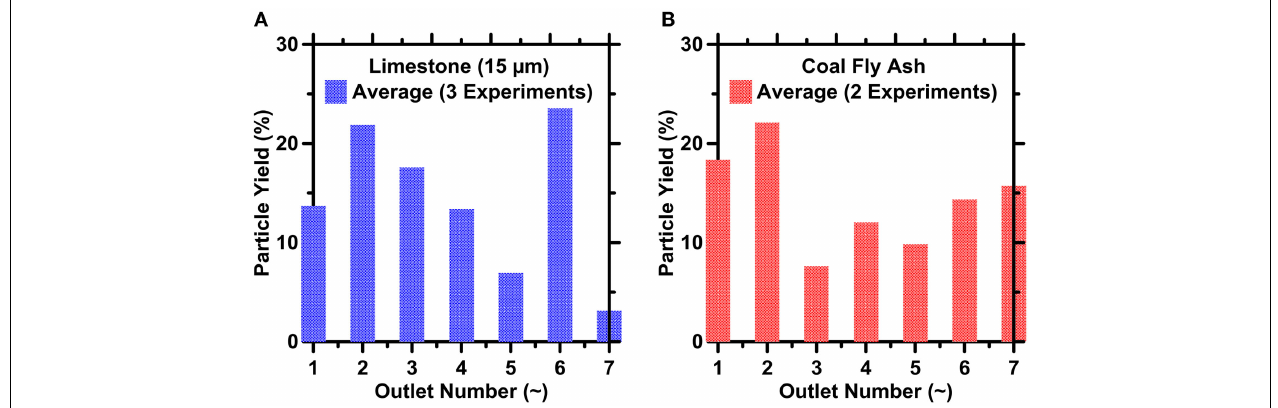
FIGURE 9 | The particle yields for (A) limestone and (B) FA particles as retrieved from the different IMF device outlets . The highest uncertainty in the particle count, and hence particle yield based on ICA on replicate images is on the order of 10% for limestone and 21% for coal fly ash, respectively.